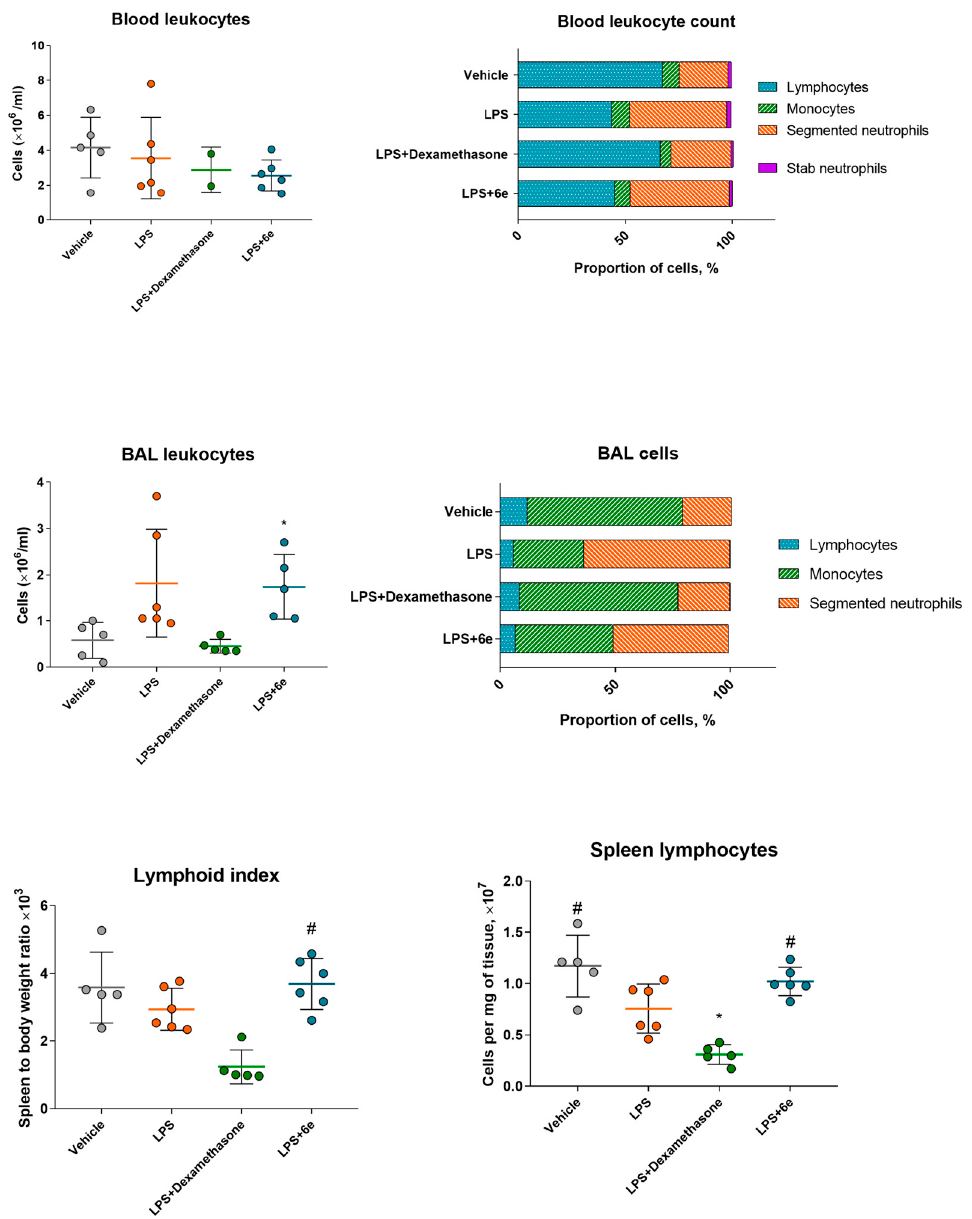
Figure 5. Effect of compounds on leukocyte counts in LPS-induced acute lung injury in C57bl/6j mice. Data are shown as mean ± SD; * p < 0.05 vs. vehicle, # p < 0.05 vs. LPS (1-way ANOVA with Dunnett’s post-test).